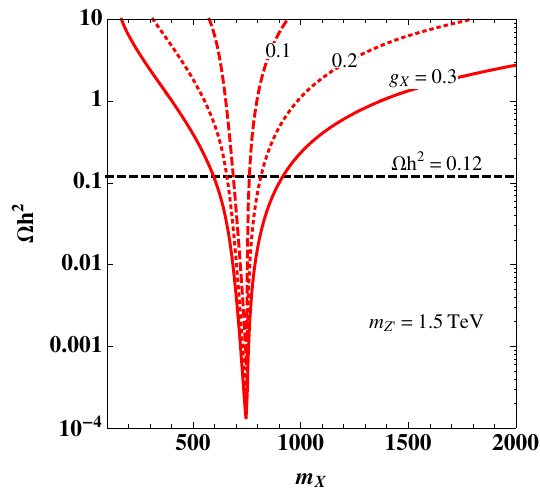
Figure 7 . Relic density of DM as a function of the DM mass for di(cid:11)erent values of U(1) X gauge couplings, g X = 0 : 1 ; 0 : 2 and 0 : 3. We have (cid:12)xed m Z 0 = 1 : 5